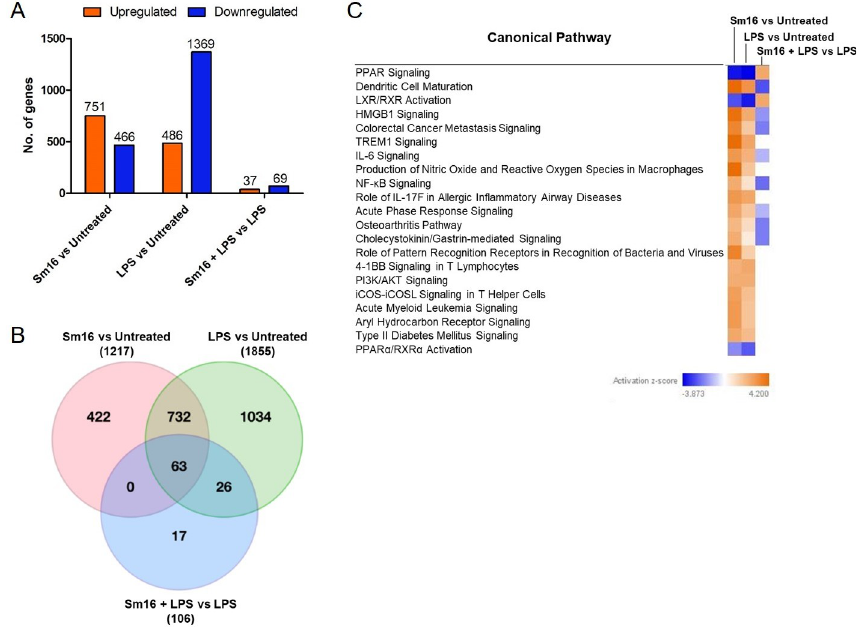
Fig 7. Sm16 (34–117) treatment significantly alters gene expression in THP-1 macrophages. THP-1 macrophages (2.5 x 10 5 ) were treated with Sm16 (34–117) (20 μ g/ml) and/or LPS (100 ng/ml) or not treated (Untreated) for 4 hrs before extracting RNA for analysis using Illumina HT12 V.4 Expression Bead Chips. Significantly (p < 0.05) differentially expressed genes were identified by ANOVA when analysing Sm16 vs Untreated; LPS vs Untreated; Sm16 + LPS vs LPS alone. Data is derived from three independently performed experiments. ( A ) Overview of differential gene expression analyses detailing total number of genes that were up- and down-regulated > 1.5 fold and < -1.5 fold, represented by orange and blue bars, respectively. ( B ) Venn diagram depicting overlap of differentially expressed genes across the respective analyses. ( C ) Canonical pathways predicted to be affected by the respective treatments as determined by IPA analysis of the differentially expressed genes ( ± 1.5 fold change). Inhibition and activation of pathways are shown by the z-score, represented by a scale of blue to orange,